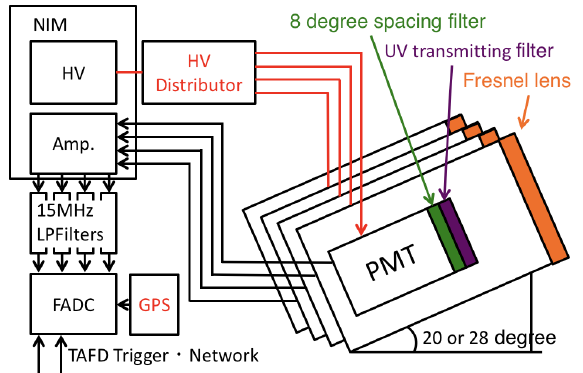
Figure 7. The block diagram of data acquisition system of CRAFFT detector for the Test observation in 2017.